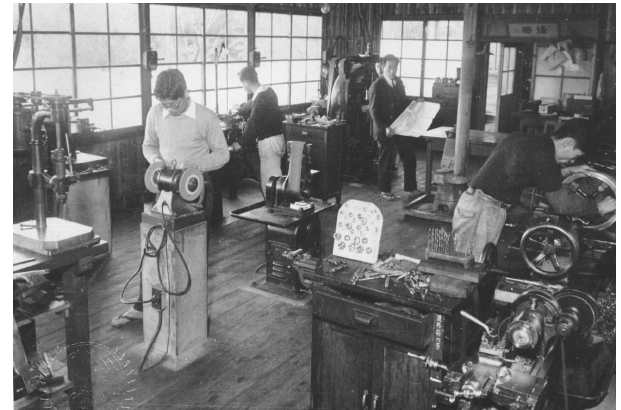
Figure 20. New variometers designed and manufactured by Kakioka Magnetic Observatory. The (left) KM-type variometer for the horizontal force and the declination and (right) the KZ-type vari- ometer for the vertical component (photo supplied by Kakioka Mag- netic